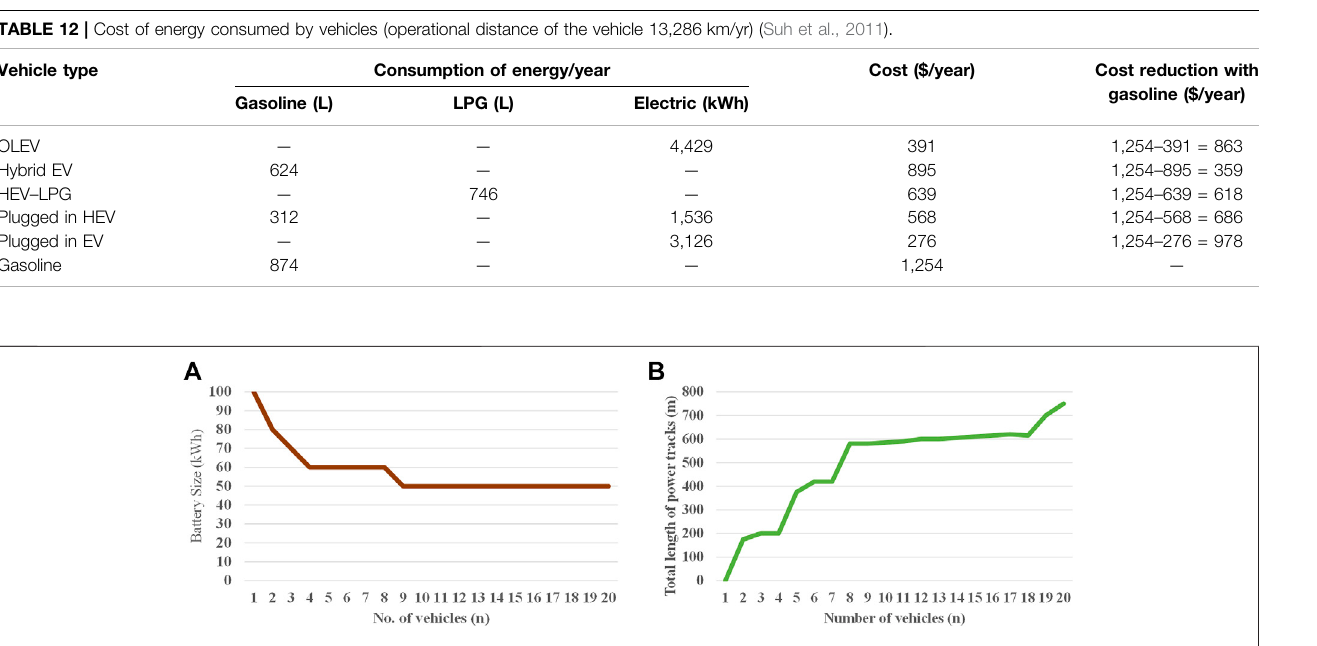
FIGURE7| Sensitivity analysisbyexpandingthevehiclecount(OLEV,Gumi City). (A) Number ofvehicles vs. battery size. (B) Number ofvehicles vs. total lengthof power tracks (Jeong et al., 2015).